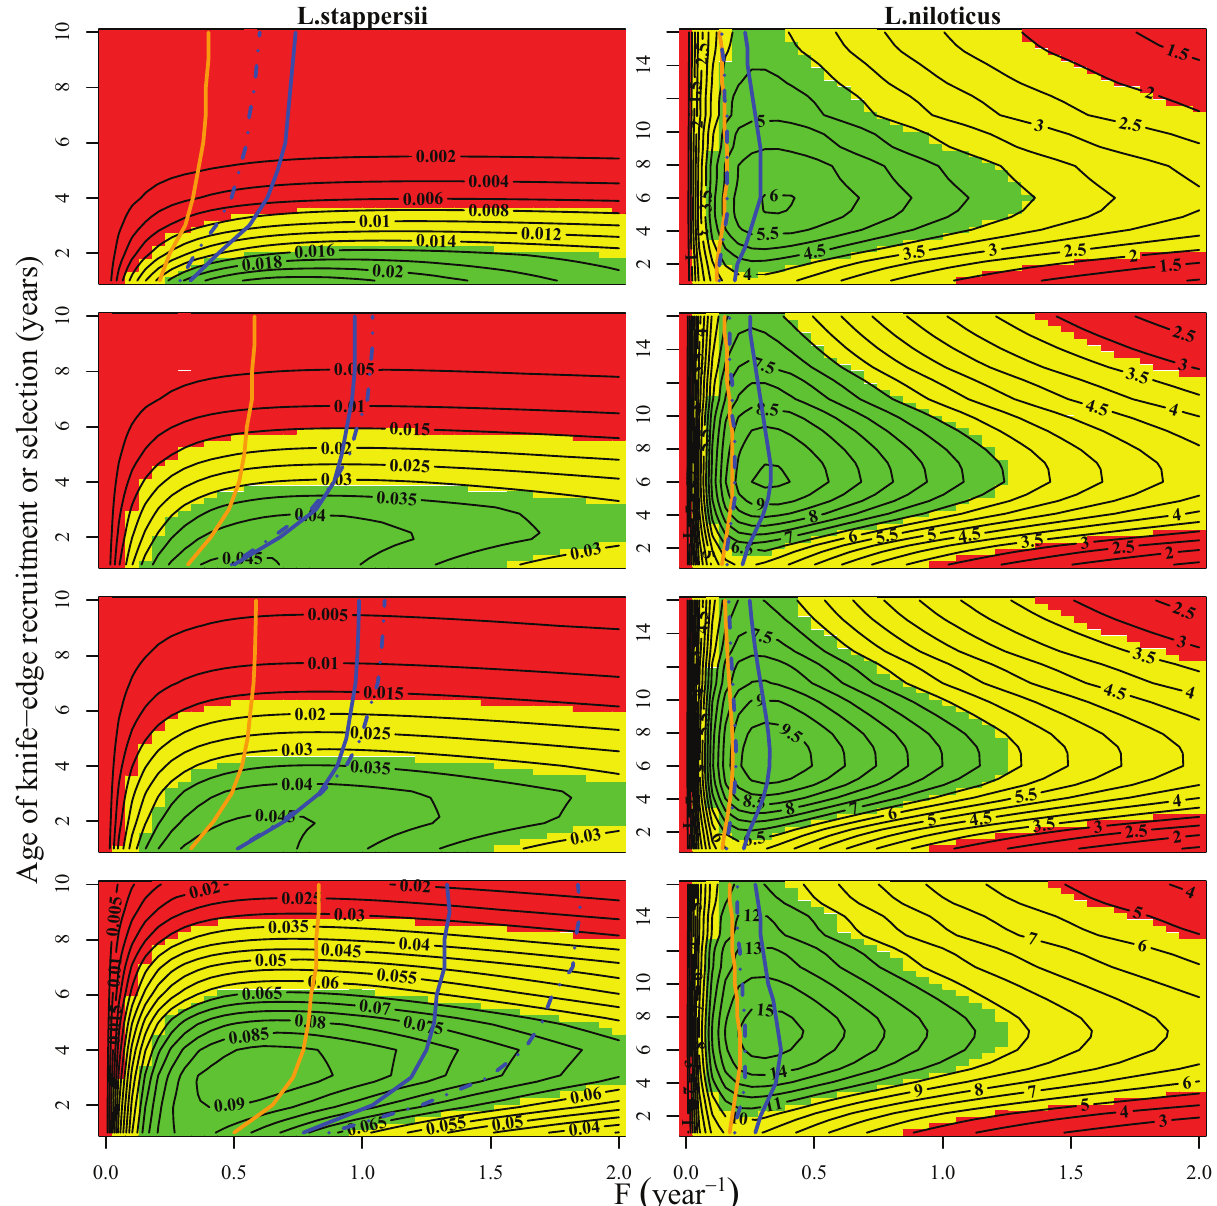
Fig. 4. Isopleths of, from top to bottom, the 2.5% percentile, median, mean, and 97.5% percentile of CYPR involving a declining survivorship (kg) as a function of fi shing mortality ( F ) and the age of knife-edge recruitment or of knife-edge selection for L. stappersii in Lake Tanganyika (left panels) and L. niloticus in Lake Victoria (right panels). The plots also show the eumetric fi shing curves of the 2.5% percentile, median, mean, and 97.5% percentile of F CYPR (blue solid line), F 0.1 (orange solid line), as well as F 35%CSPR for L. stappersii and F 40%CSPR for L. niloticus (blue dash-dotted line) against the age of knife-edge recruitment. Areas shaded by the red color, yellow color, and green color are, respectively, topographies of low CYPR, intermediate CYPR, and high CYPR. If F CYPR , F 0.1 , or F at a target CSPR is treated as the fi shing mortality target, the region below and to the right of the corresponding lines represents growth-over fi